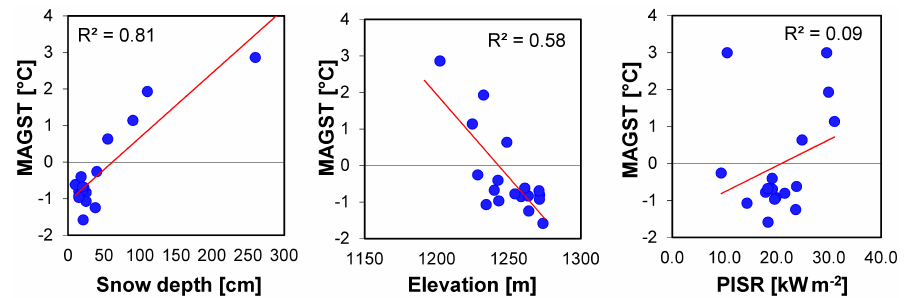
Figure 10. Linear regression line between the mean annual ground surface temperature (MAGST) in 2014 and snow depth, elevation, and potential incoming solar radiation